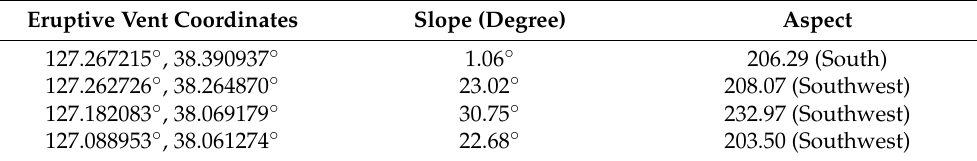
Table 5. Probable eruptive vent proposed to simulate the multiple vent eruption. Eruptive Vent